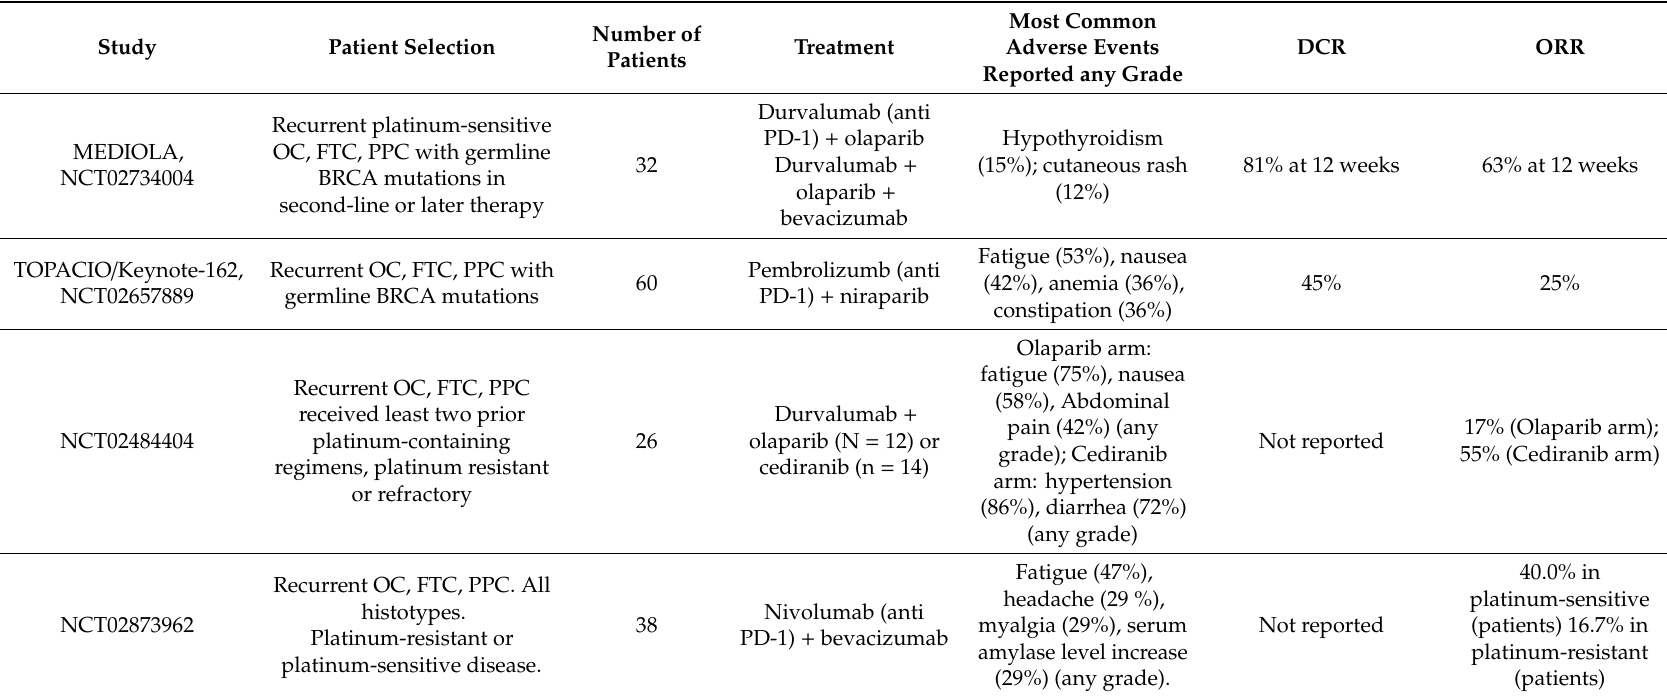
Table 3. Results in trials exploring combination therapy (ICIs + PARPi or